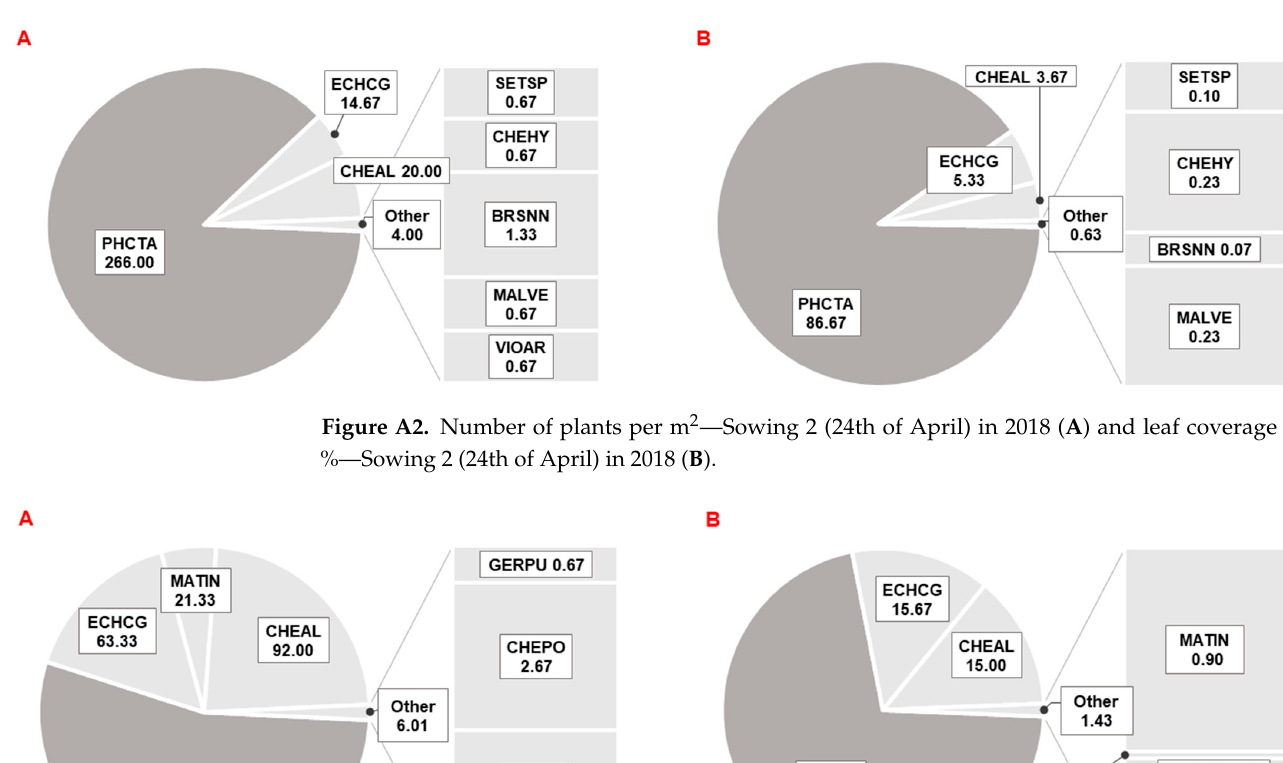
Figure A1. Number of plants per m 2 —Sowing 1 (12th of April) in 2018 ( A ) and leaf coverage in %— Sowing 1 (12th of April) in 2018 ( B ).